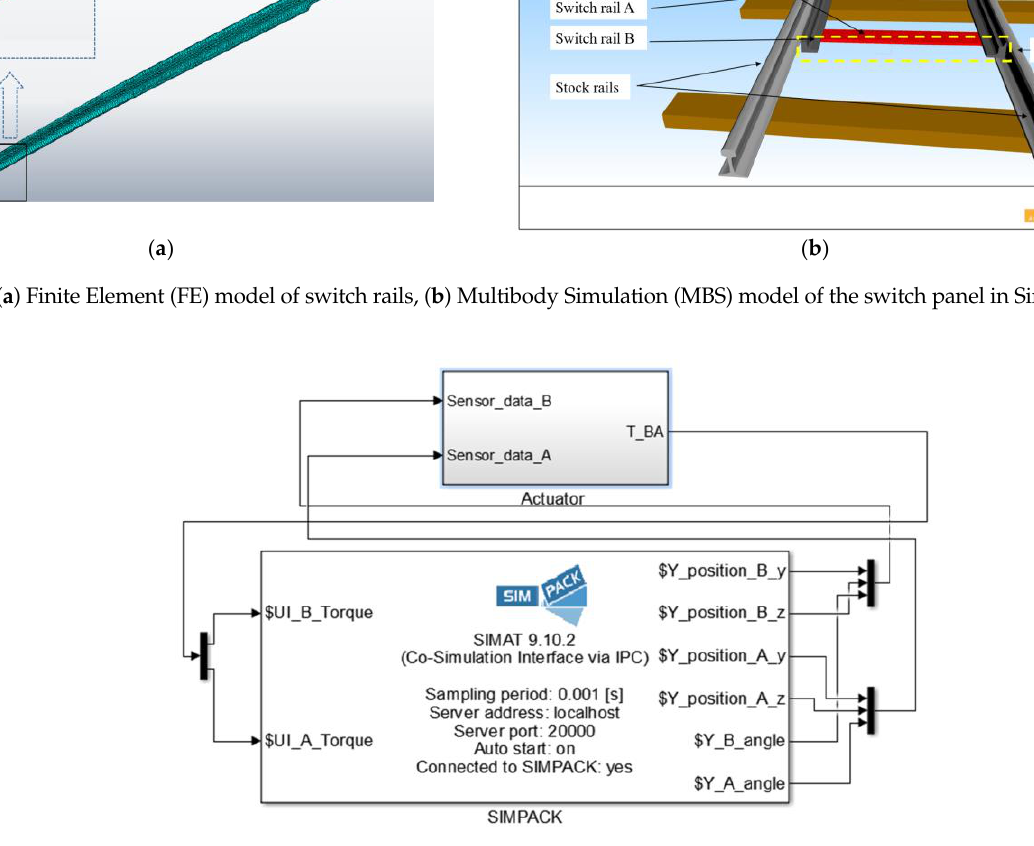
Figure 7. Co-simulation of the switch system.